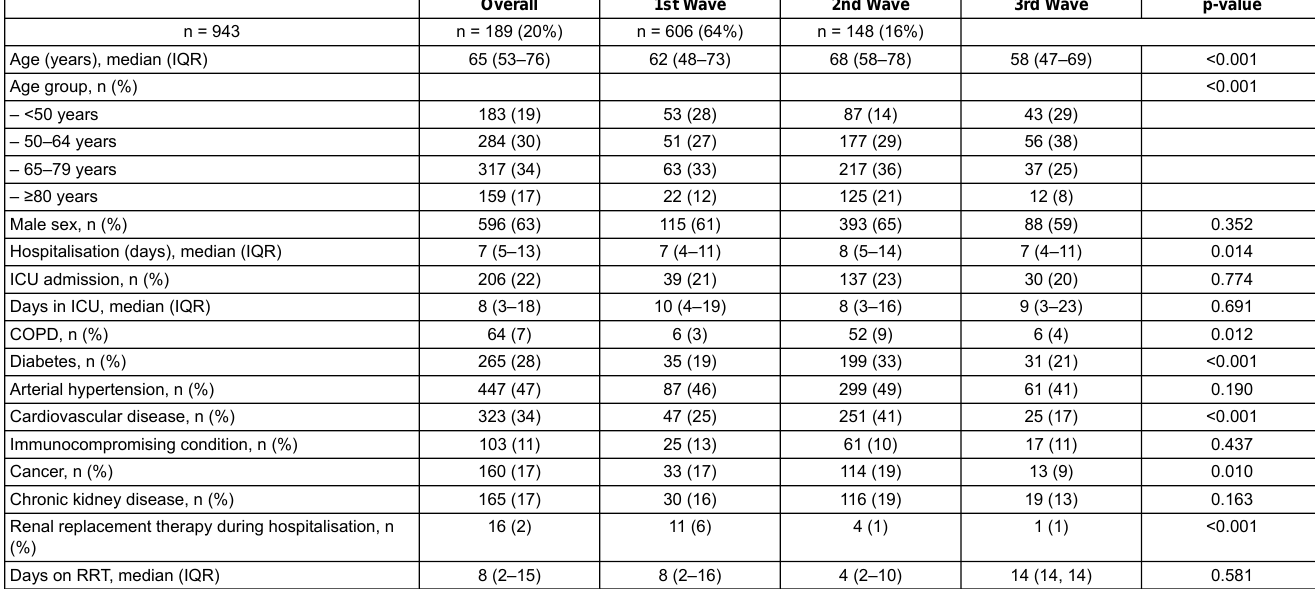
Table 1: Baseline characteristics of all patients and stratified by wave. Overall 1st Wave 2nd Wave 3rd Wave